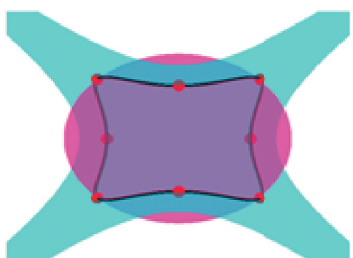
Figure 13: xy -view of intersection along with boundary and turning points.